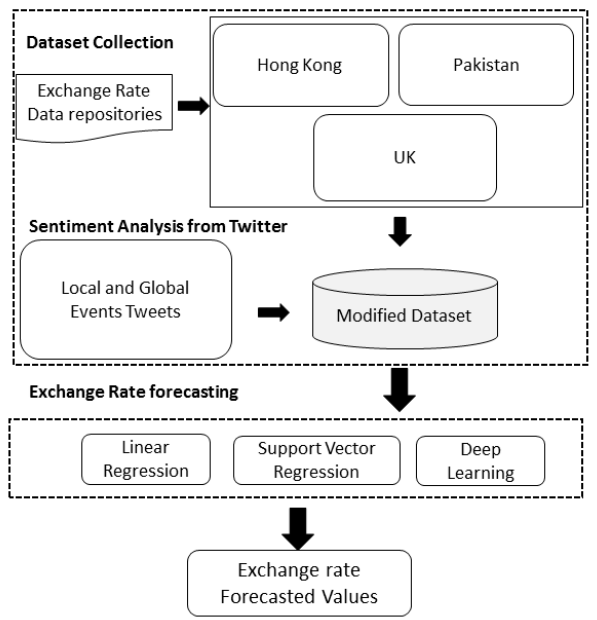
Figure 1. The proposed methodology for the foreign exchange rate prediction.